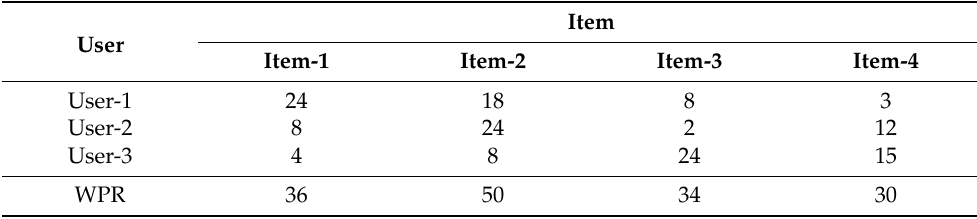
Table 5. The results of the weight point